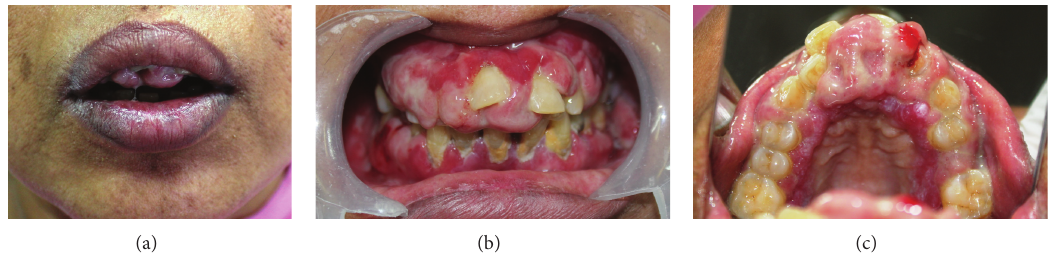
Figure 1: (a) shows incompetent lips due to gingival overgrowth. (b) and (c) show intraoral gingival enlargement with erythematous lesion, spontaneous bleeding sites, calculus, and purulent discharge.